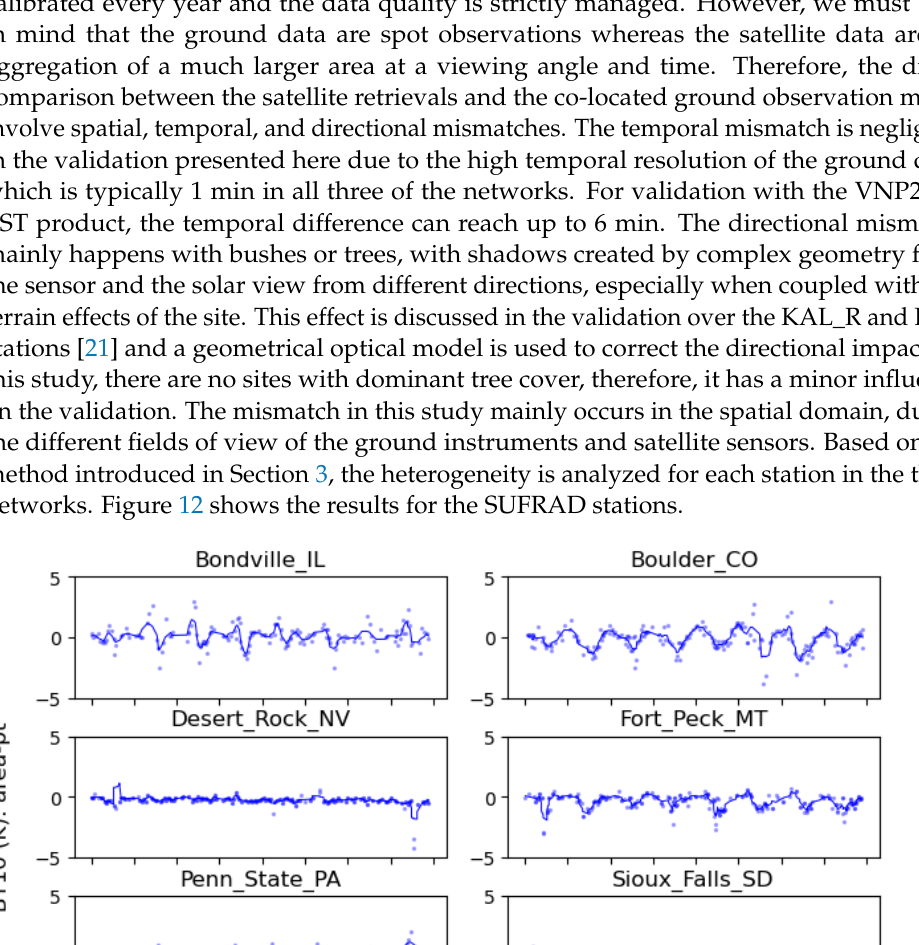
BT10 of a 1 km spatial area during the late spring and colder BT10 during the summer